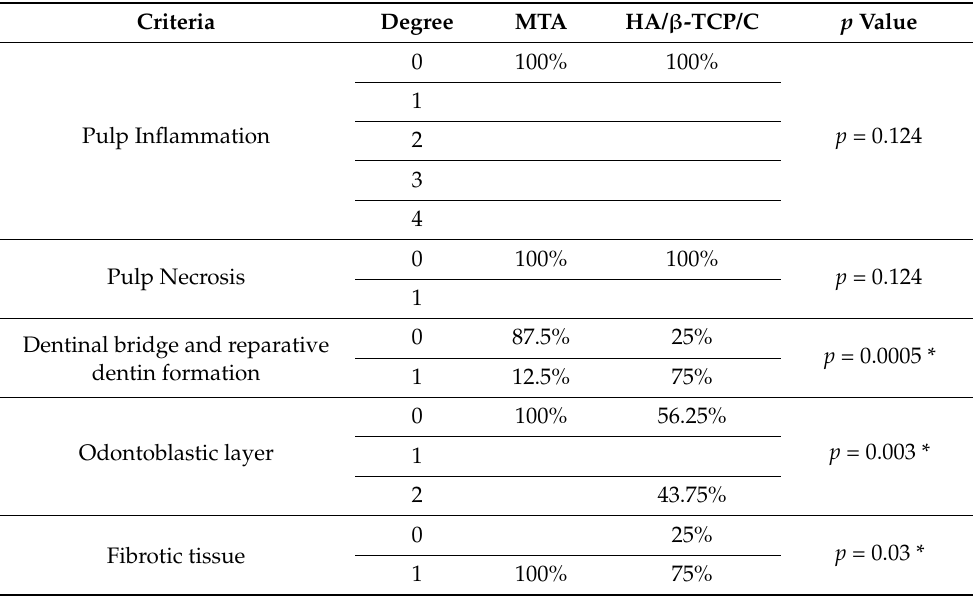
Table 2. Histological results of each experimental group. * p <